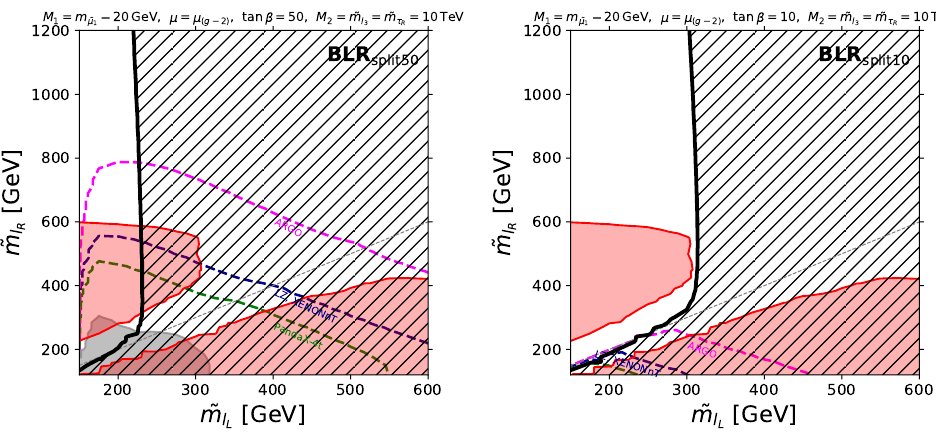
and ˜ m are taken to be 10 TeV independently from Figure 5 . Similar planes to figure 4 but ˜ m l τ R 3 the other slepton masses. The value of tan β is taken to be 50 and 10 in the left and right plots, respectively. The µ -parameter is fixed such that it fits the central value of the ( g − 2) measurement. µ The hatched region and the grey shaded regions are excluded by the dark matter overproduction and the Xenon-1T limit, respectively. The red shaded region is excluded by the LHC constraint from the CMS ‘ + ‘ − analysis. The region below the dashed magenta, blue and green contours can be probed by the future ARGO, LZ/XENONnT and Panda-4t direct detection experiments,